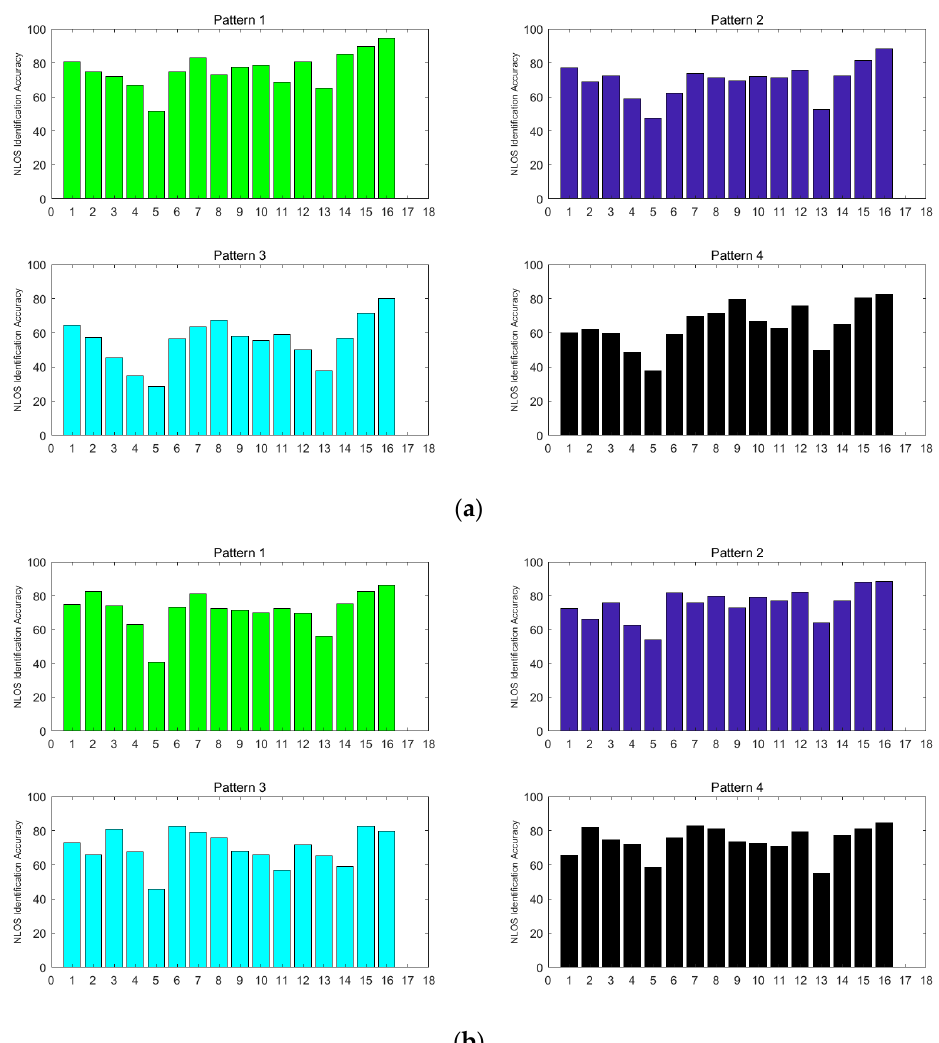
Figure 9. NLOS identification accuracy based on different methods. ( a ) Single receiving accuracy comparisons of four dynamic NLOS patterns.; ( b ) dual-receiving accuracy comparisons of four dynamic NLOS patterns.